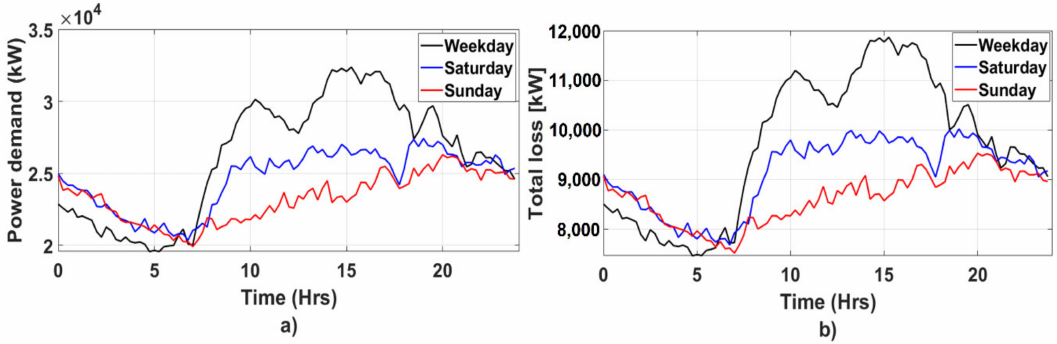
Figure 18. ( a ) Power demand curve; ( b ) Total loss curve.